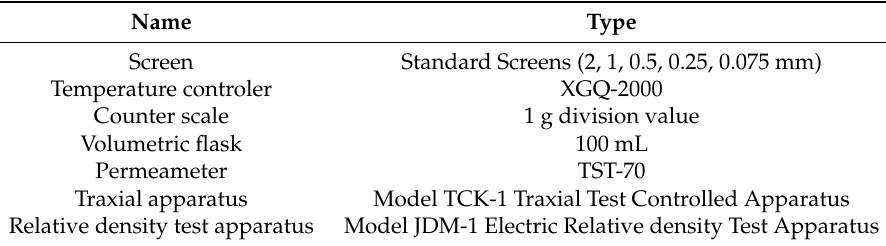
Table 2. Sand parameter measuring equipment.